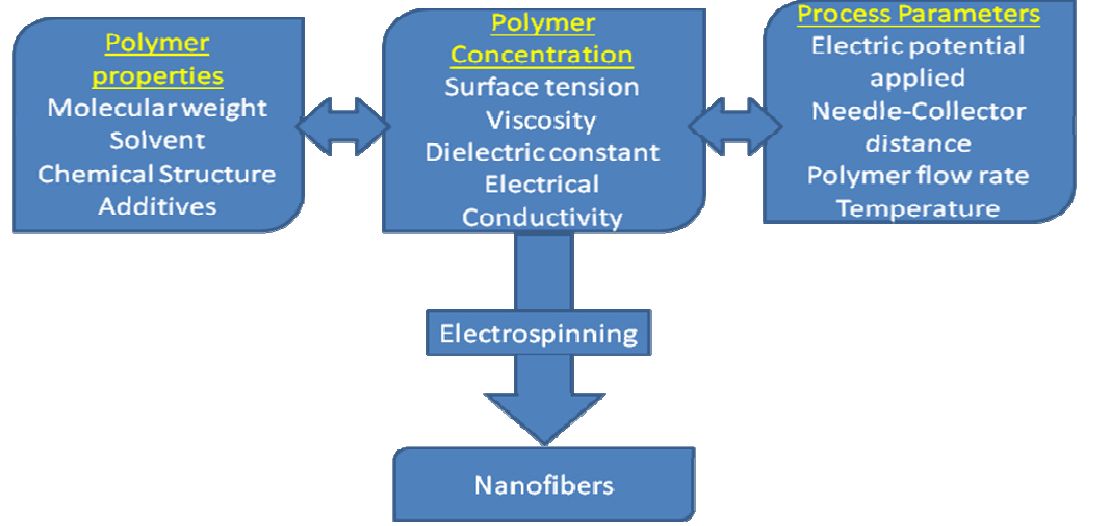
Figure 1. Overall parameters involved in electrospinning